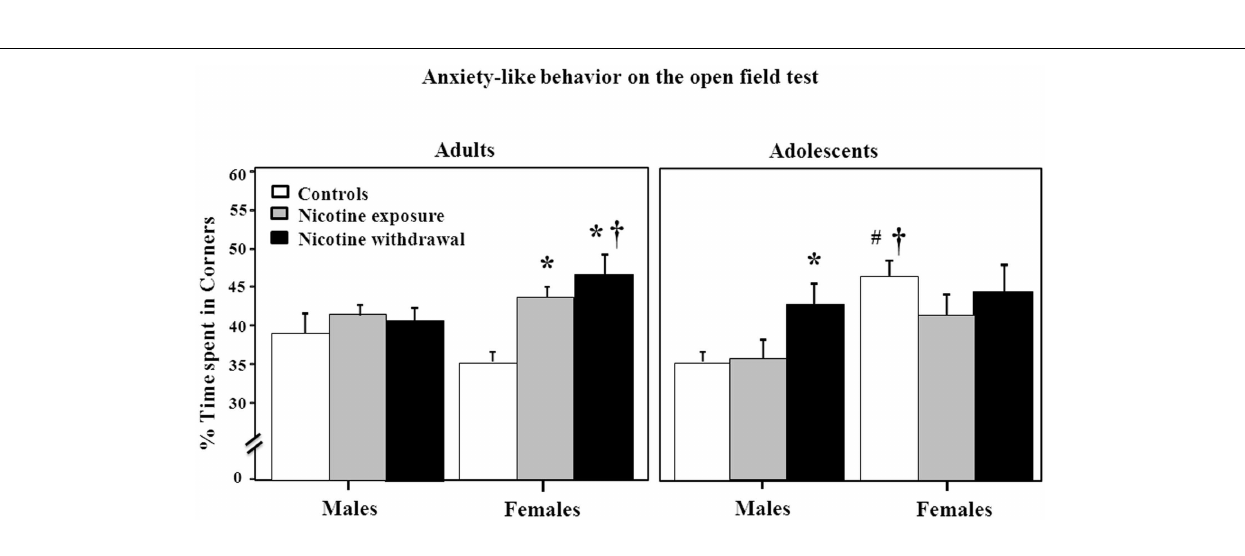
FIGURE 3 | Percent time spent in the corner areas in the open-field testing during nicotine exposure and withdrawal in adult male (control n = 9; nicotine exposure n = 15; nicotine withdrawal n = 10), adult female (control n = 10; nicotine exposure n = 16; nicotine withdrawal n = 13), adolescent male (control n = 6; nicotine exposure n = 5; nicotine withdrawal n = 5), and